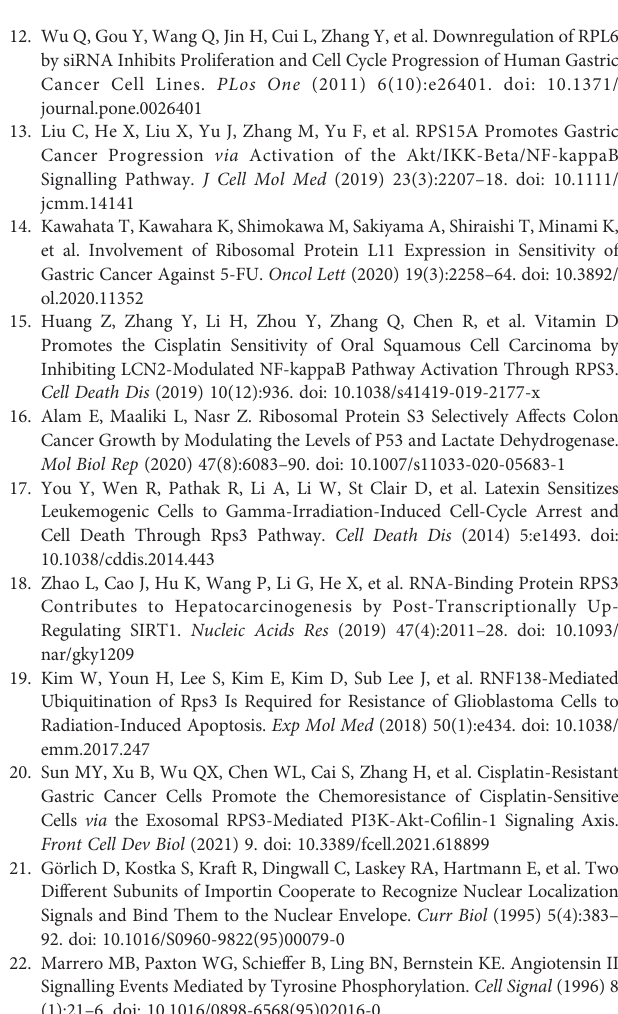
Supplementary Figure 1 | Knockdown of RPS3 inhibited ACC invasion of the sciatic nerve and lung metastasis in nude mouse model. (A) Dissection of the hindlimb on the tumor-bearing side of the mouse. The sciatic nerve in the RPS3 knockout group was the same as that in the blank group; the sciatic nerve in the control group was wrapped and squeezed by the tumor. (B) The lung tissue samples of nude mice in the control group and RPS3 knockdown group. The tumors was observed in the control group, and the lung tissue without tumor in the knockdown group. Supplementaty Table 1 | The occurrence of lung metastases after RPS3 knockdown. Supplementary Video 1 | Blank group mouse model sticker experiment. Supplementary Video 2 | Sh-RPS3 group mouse model sticker experiment. Supplementary Video 3 | Control group mouse model sticker